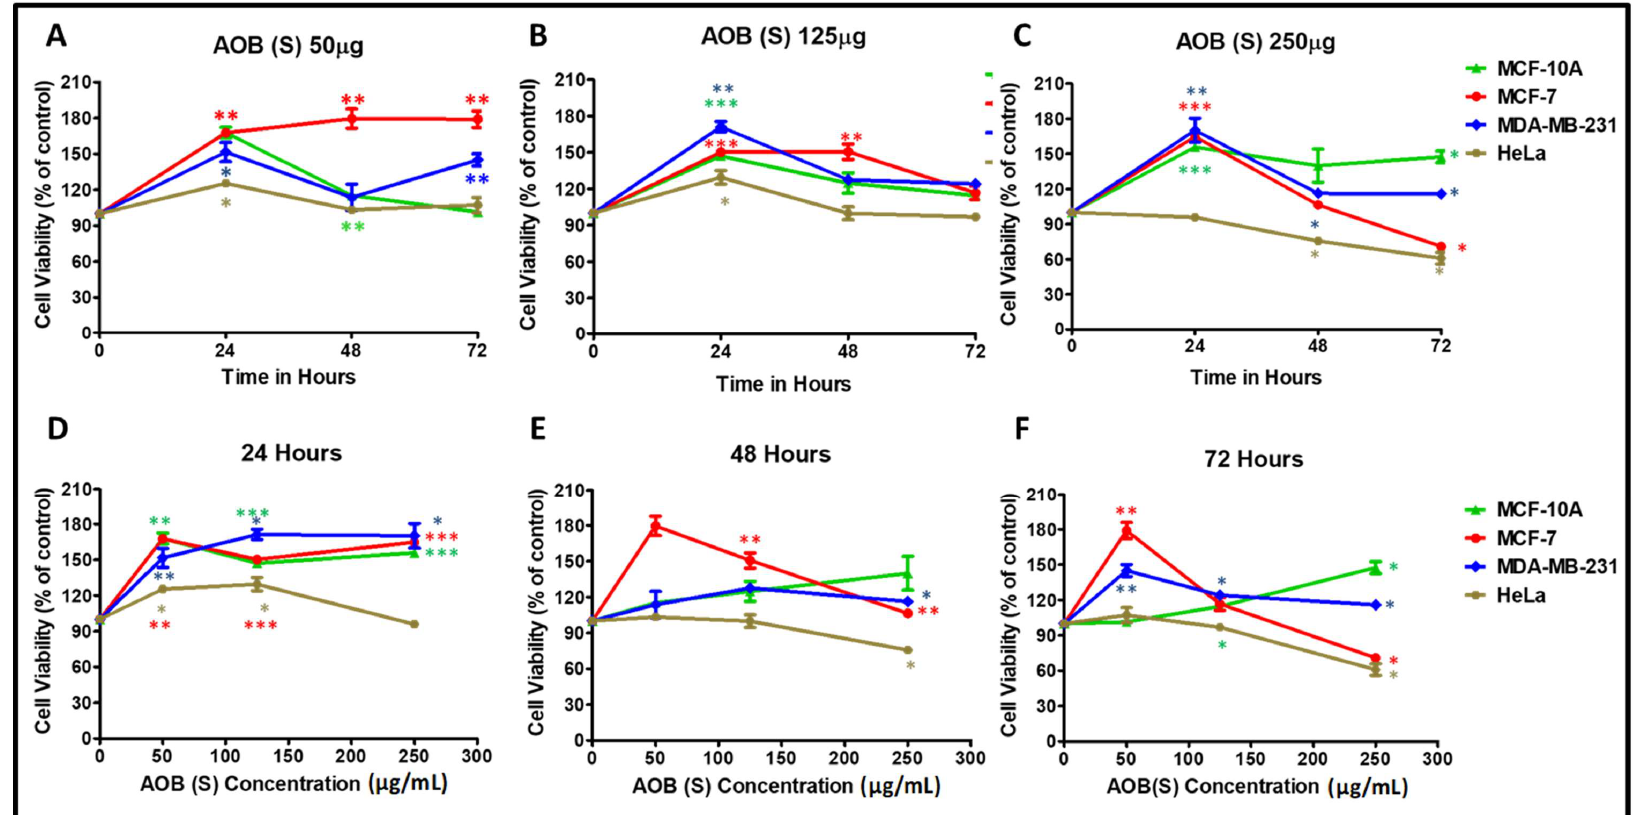
Figure 2. Cytotoxic effects of A. orientalis dichloromethane leaf fraction (AOB (S)) using the MTT assay on MCF-10A, MCF-7, MDA-MB-231, and HeLa cells in a dose- ( A – C ) and time- ( D – F ) dependent manner after normalizing to the effects of DMSO solvent used to dissolve the extract. *indicates statistically significant differences between the DMSO- and AOD (L)-treated samples (* p <0.05; ** p <0.01 but >0.001; *** p <0.001).